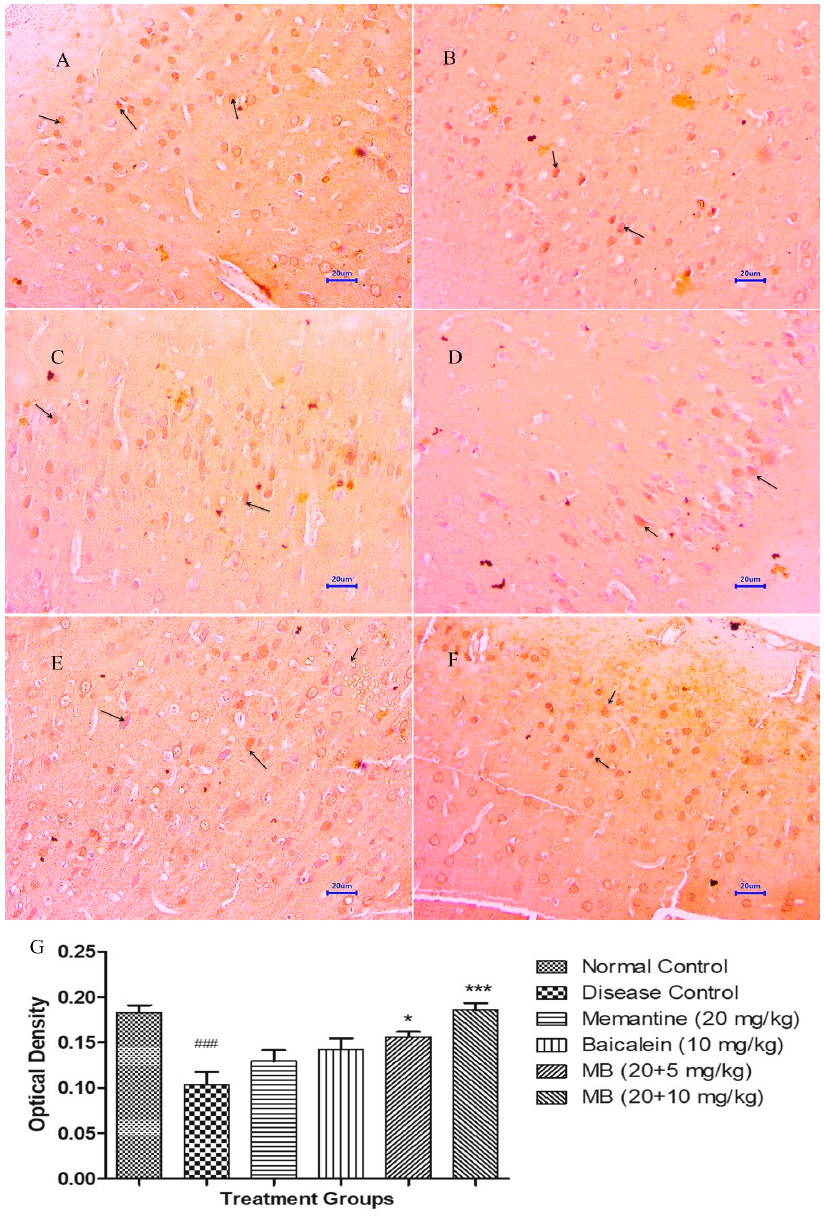
Figure 13. Effect of A β (1–42), baicalein and baicalein with memantine on BDNF expression in hippocampus tissue (400 × ). ( A ) Normal control: displaying moderate expression of BDNF (arrow) revealed by brown colouration in cortex. ( B ) Disease control: displaying mild expression of BDNF (arrow), revealed by brown colouration in cortex. ( C ) Memantine 20 mg/kg: displaying mild expres- sion of BDNF (arrow), revealed by brown colouration in cortex. ( D ) Baicalein (10 mg/kg): displaying mild expression of BDNF (arrow) revealed by brown colouration in cortex. ( E ) Memantine + Baicalein (20 + 5 mg/kg): displaying mild to moderate expression of BDNF (arrow), revealed by brown colouration in cortex. ( F ) Memantine + Baicalein (20 + 10 mg/kg): displaying moderate expression of BDNF (arrow), revealed by brown colouration in cortex. ( G ) OD data for ICH, Data are represented as mean ± SEM, where ### p < 0.001 indicates comparison with normal control, whereas * p < 0.05 and *** p < 0.001 indicates comparison with disease control group; SEM, Standard Error of Mean; MB: memantine + baicalein.